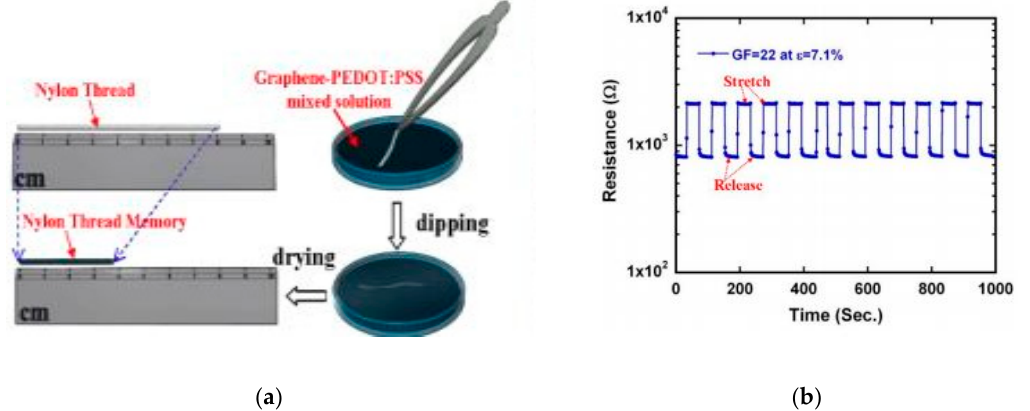
Figure 7. A graphene-PEDOT:PSS coated nylon thread: (a) schematic of the simple two-step dip-and-dry solution process for the fabrication (right) and the actual picture of the sample with the length reduction from 80 to 29.48 mm after dip-and-dry; ( b ) resistive memory strain sensor thread at many stretch and release cycle under applied a fixed ε = 7.1%. Adopted from [92]